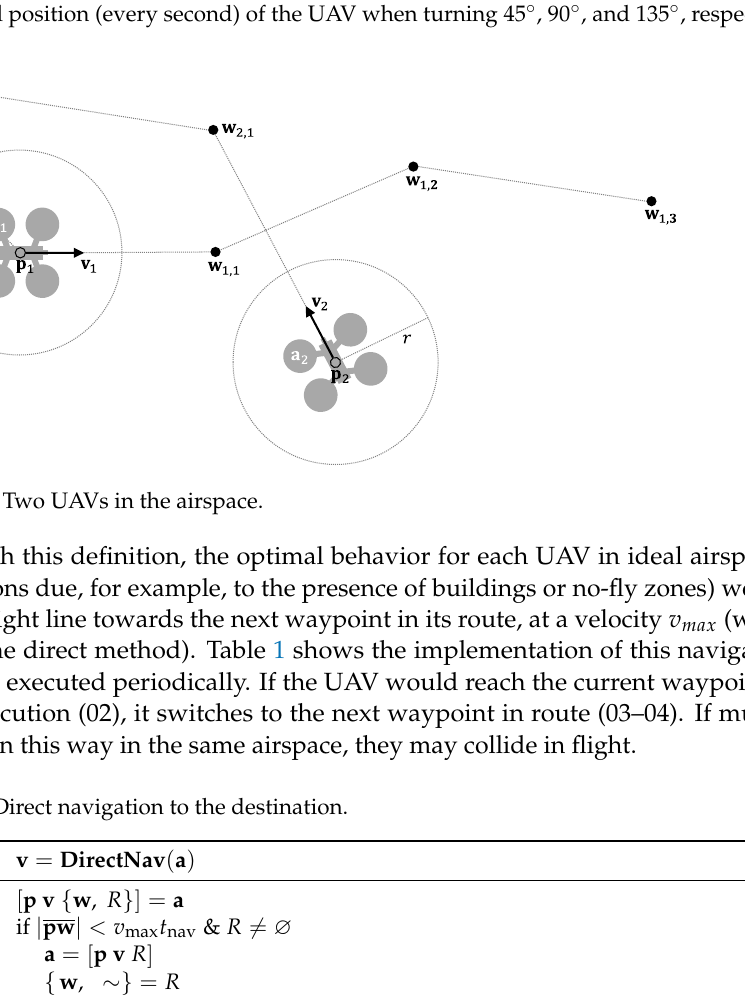
. (cid:12) (cid:12) p (cid:12) (cid:12) = | v | = 10 m/s); the blue line shows its dynamic trajectory 0